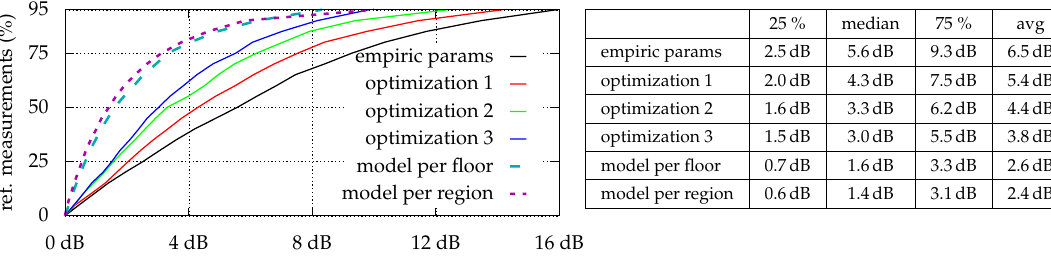
Figure 4. Cumulative error distribution for all optimization strategies. The error results from the (absolute) difference between model predictions and real-world values for each reference measurement. The higher the number of variable parameters, the better the model resembles real-world conditions.